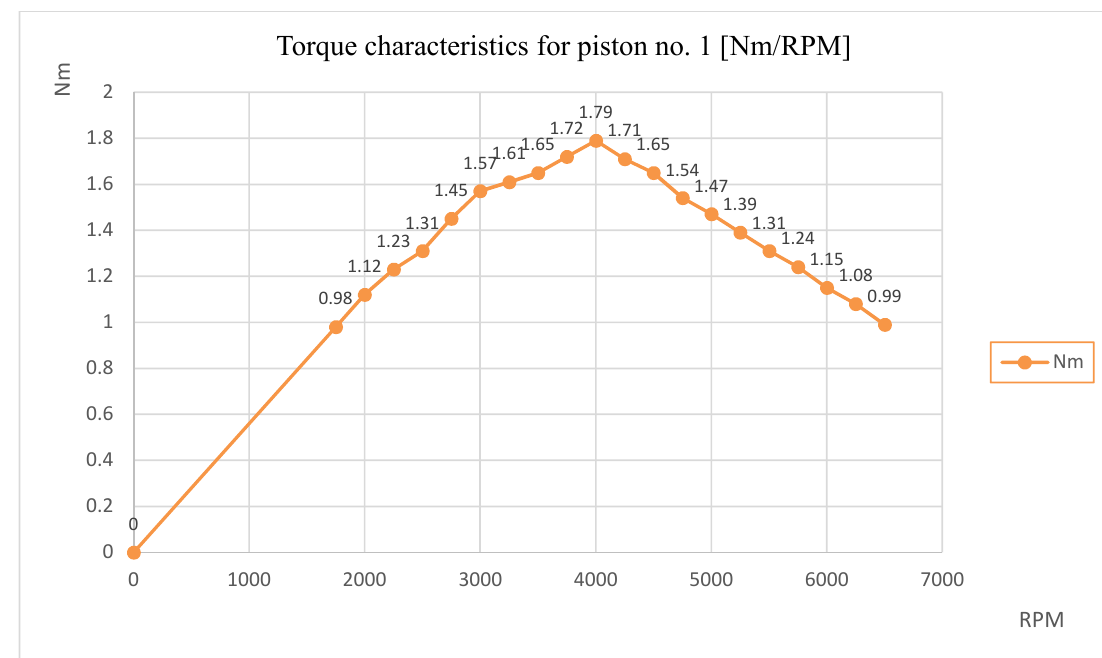
Figure 19. Engine torque characteristics for piston no. 1.